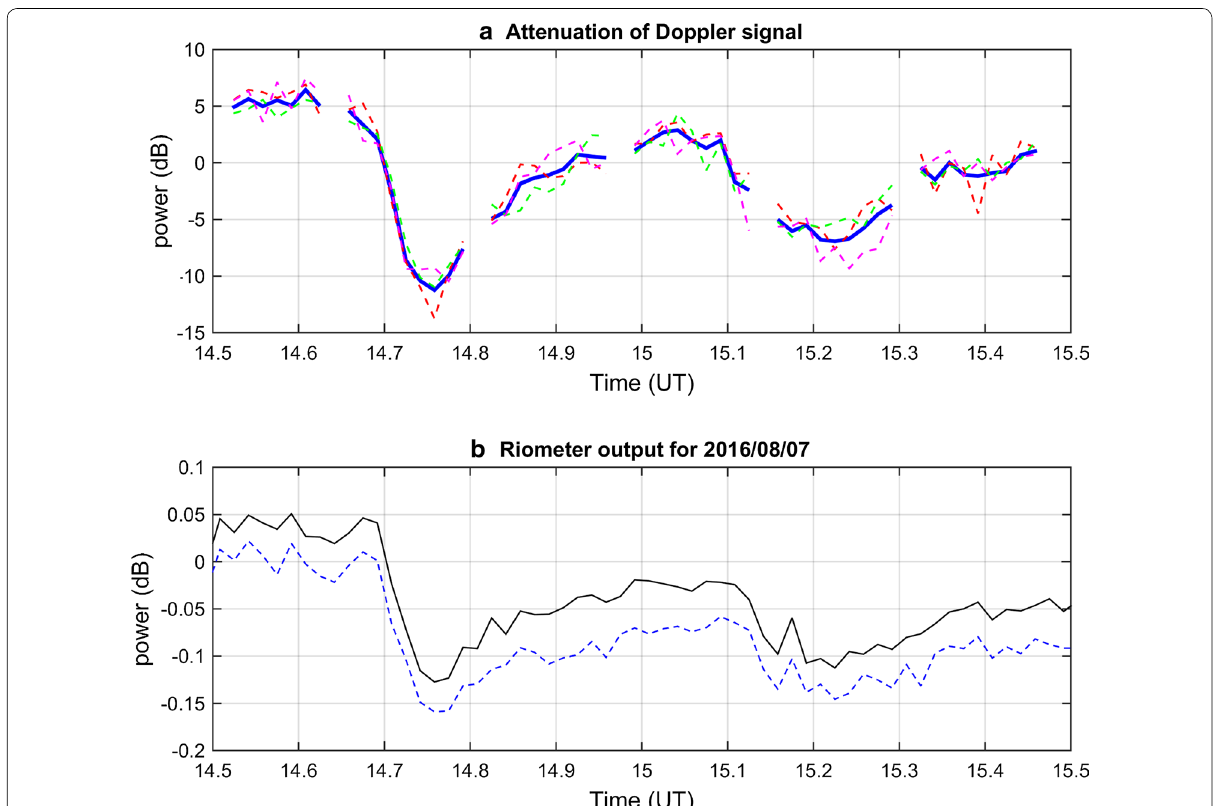
Fig. 11 Relative attenuation of Doppler signals at 4.63 MHz measured in Tucumán on 7 August 2016 during M1.3 and C8.5 X‑ray solar flares from 14:30 to 15:30 UT. a Attenuation of Doppler signal, solid blue averaged over three sounding paths, dashed for individual sounding paths. b Attenuation measured by nearby riometer at 38.2 MHz, solid black only for 7 August 2016, dashed after subtracting the quiet day curve (QDC) obtained from 1 month